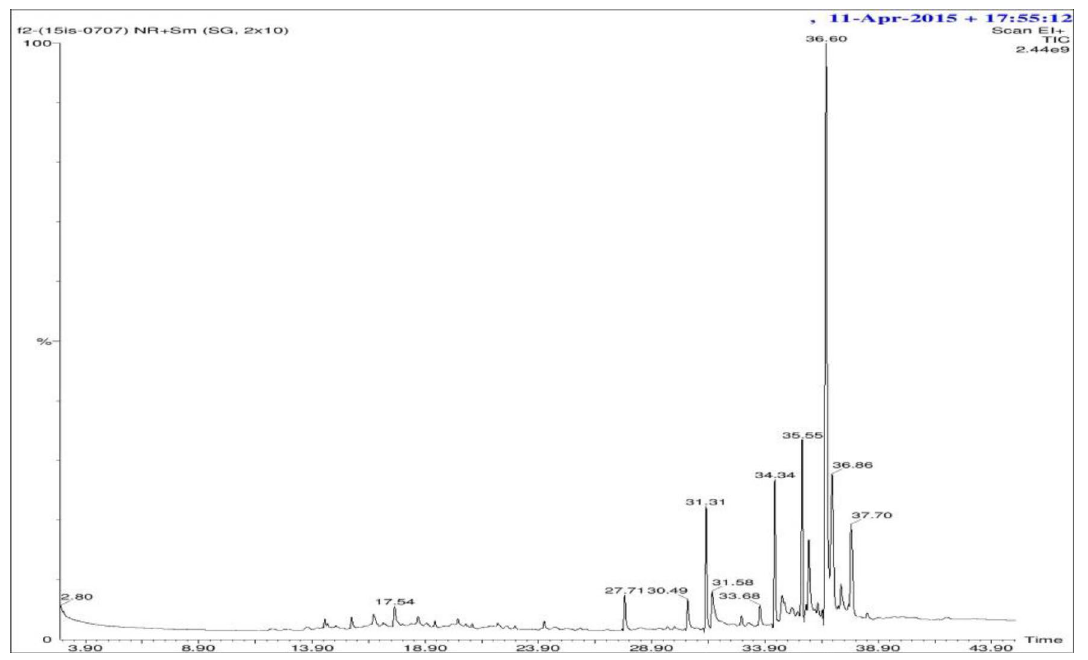
Fig. 2 GCMS chromatogram of F2 fraction